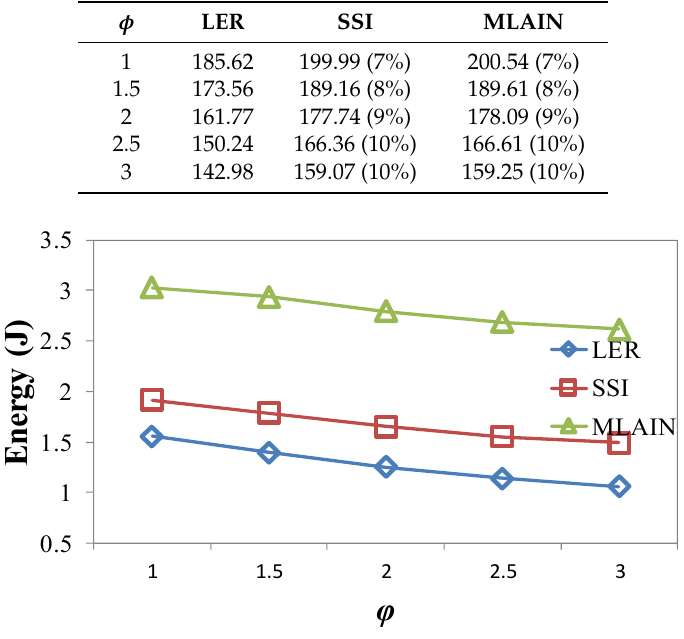
Figure 14. Average energy consumption for changing φ values .